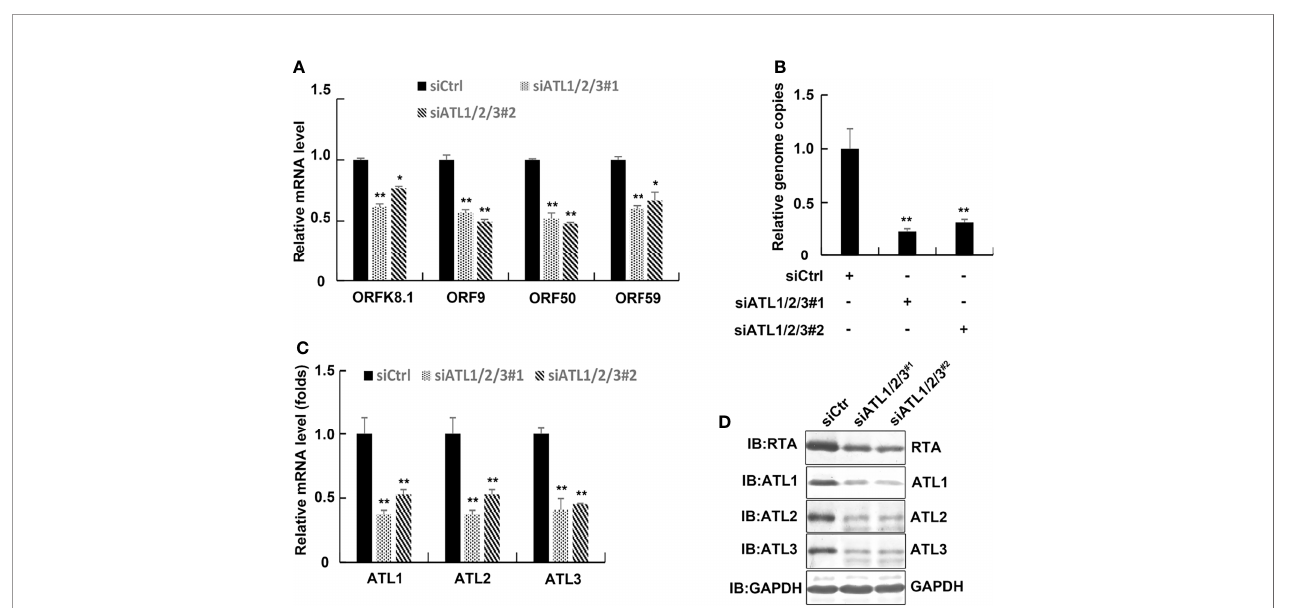
FIGURE 4 | Silencing of ATLs impairs spontaneous KSHV lytic reactivation in iSLK.rKSHV.219 cells. iSLK.rKSHV.219 cells were transfected with siCtrl, siATL1/2/ 3#1 or siATL1/2/3#2 respectively. Forty eight hours later, mRNA levels of KSHV lytic genes ORFK8.1 , ORF9 , ORF50 , and ORF59 were measured by RT-qPCR, with normalization to actin using the DD CT method (A) . Viral DNA in the media was quanti fi ed using qPCR, with normalization to an added plasmid FAM105B using the DD CT method (B) . Knockdown ef fi ciencies of siATL1/2/3 in iSLK.rKSHV.219 cells were measured by RT-qPCR (C) . Data are presented as means of three technical replicates (n = 3, group values are indicated by mean ± SEM; *p <0.05; **p <0.01). (D) Proteins were detected by western blot with indicated